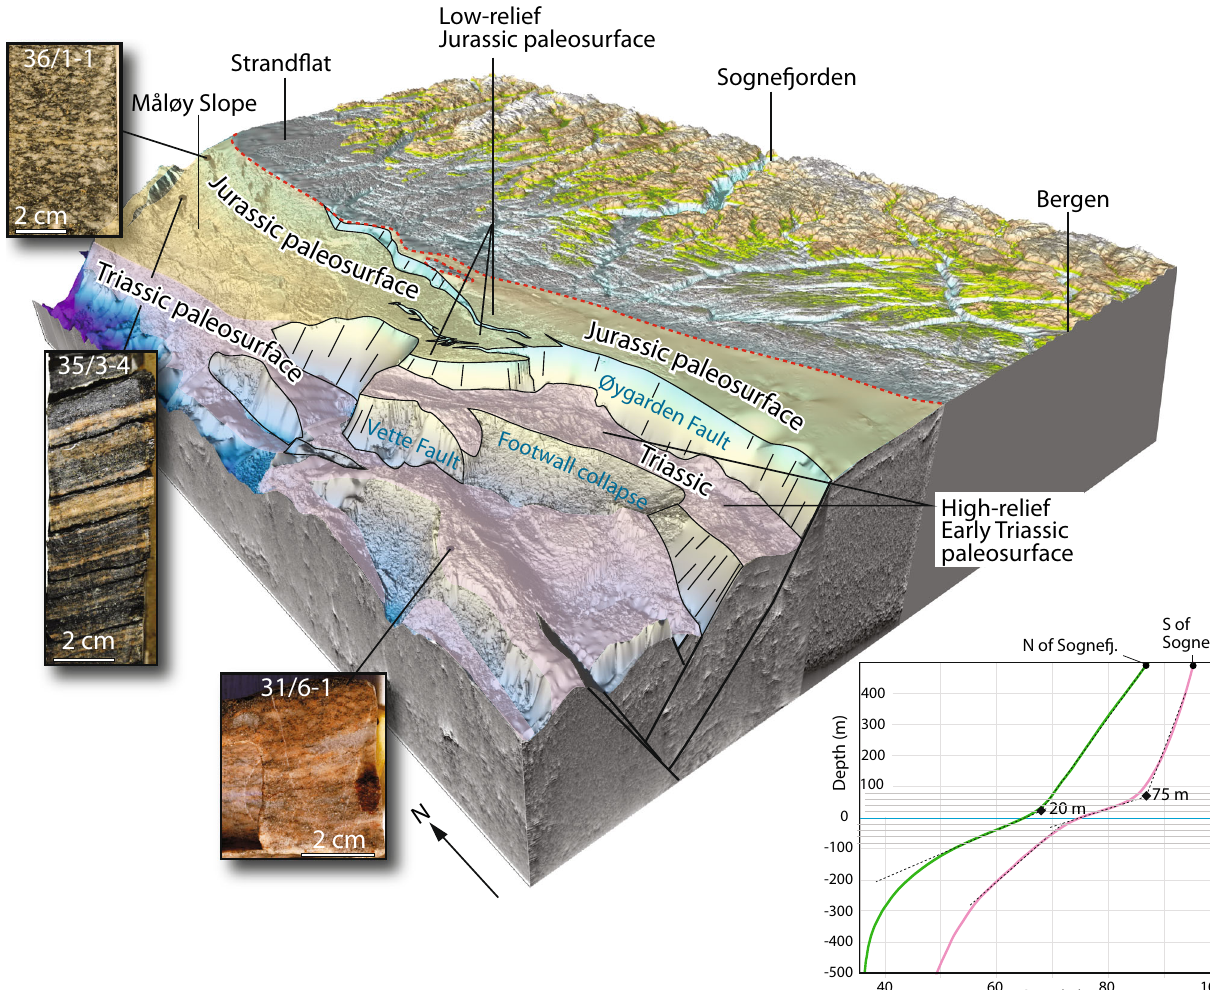
Fig. 4 3D view of the top crystalline basement onshore-offshore from Bergen to Stad. Offshore sediments have been removed to expose the basement. Three domains are recognizable: the glaciated onshore mountain-fjordscape, the near sea level strand fl at, and the sloping and faulted paleo-topography of Jurassic and Triassic age. Figure prepared from onshore elevation data, bathymetric data and offshore seismic data. Graph shows hypsometric curves of the northern and southern parts of this area. The curves show a low-dip segment that relates to the strand fl at, although the upper break in slope is better de fi ned than their lower one. Both the upper and lower breaks in slope are lower for the northern part than for the southern part, re fl ecting the northward lowering of the strand fl